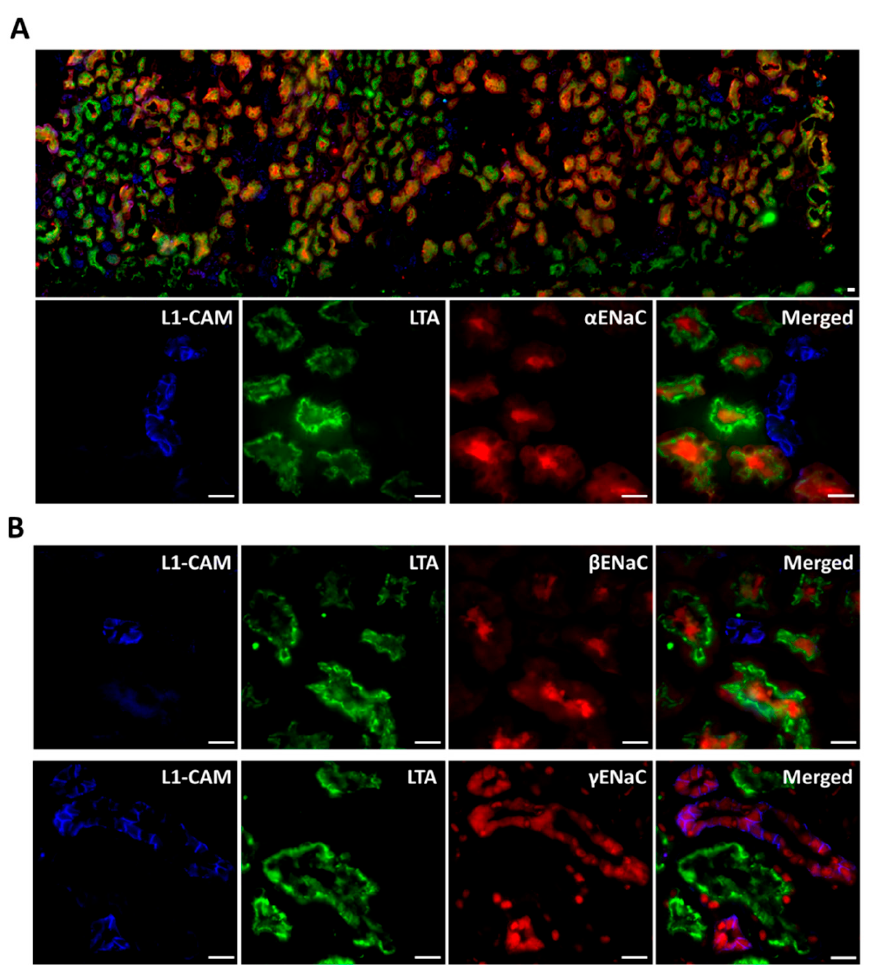
Figure 3. 𝛼 ENaC, β ENaC, and γ ENaC staining in human renal cortex. ( A ) The upper panel was a montage showing the overall 𝛼 ENaC, L1-CAM, and LTA staining in the whole slice of the tissue; the lower panel showed the close-up images. ( B ) Representative image of β ENaC and γ ENaC staining in kidney tissue. α , β , and γ ENaC were stained in red. LTA was a PTC marker in green. L1-CAM, a CD marker, was in blue. (Scale bar = 10 µm.)